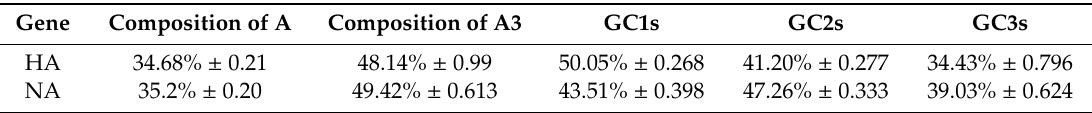
Table 1. Nucleotide composition.